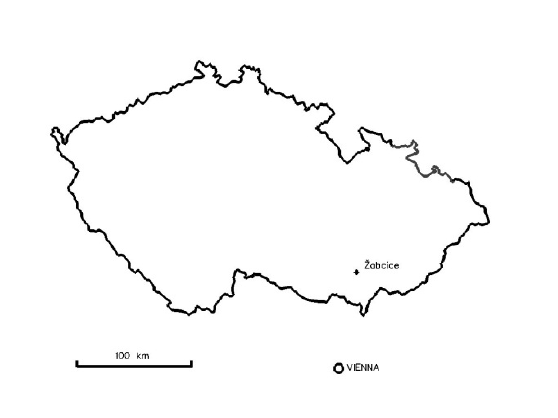
Figure 1. Simplification of forest